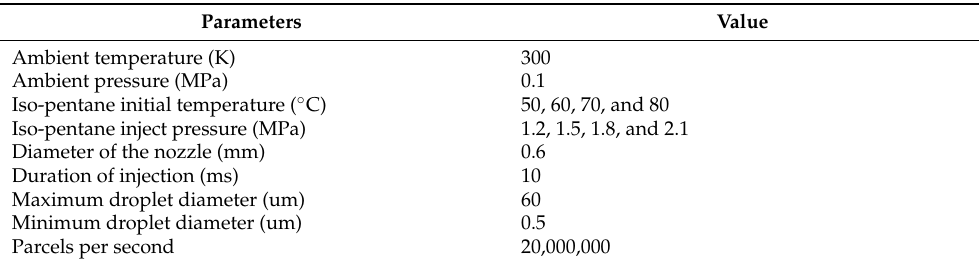
Table 1. Initial parameters for numerical study.